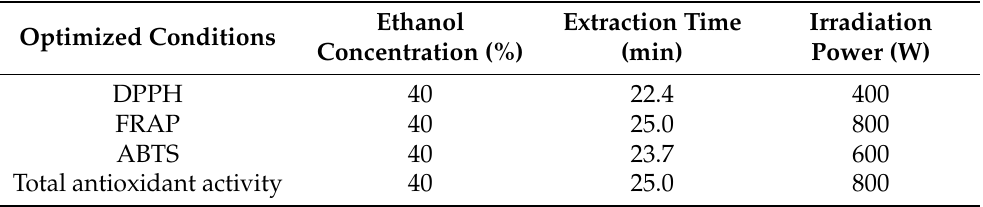
Table 3. Optimal MAE conditions for carob flour